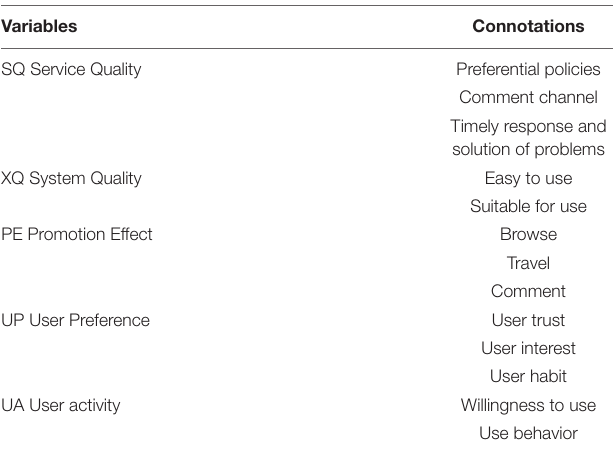
with the respondents’ willingness and behavior to use the app continuously. Service quality and system quality come from the D&M information system success model. The promotion effect is the extended variable based on the D&M information system success model. User preference is the extended variable too, which comes from the technology acceptance model. See Table 1 for variables’